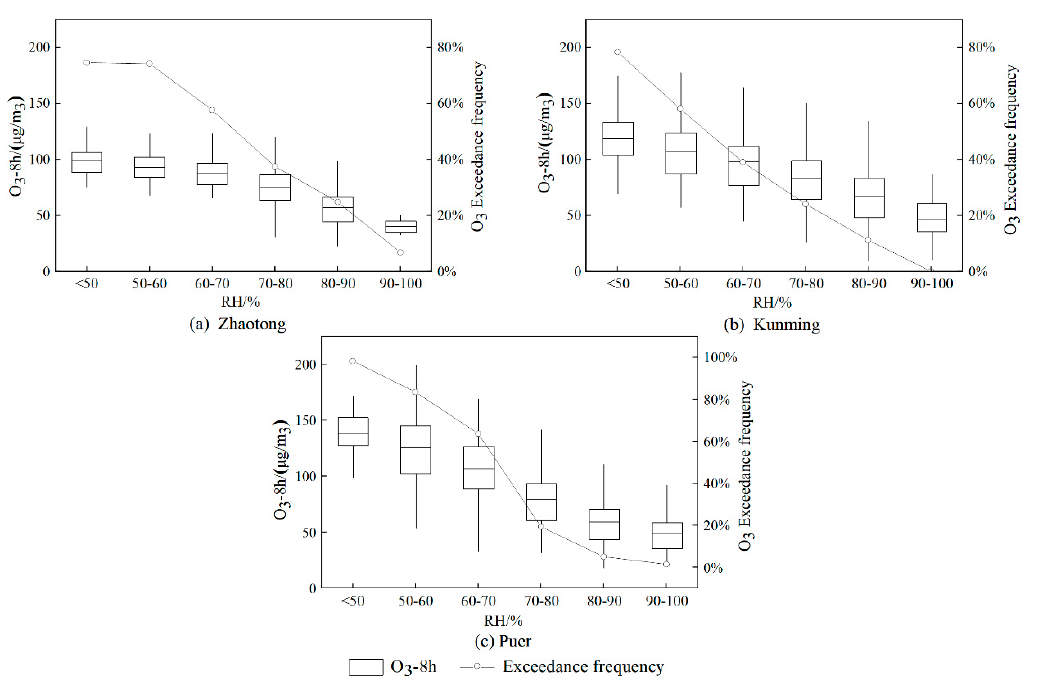
Figure 9. Changes from relative humidity and O 3 concentration, exceeding standard frequency between Zhaotong, Kunming and Pu’er. Table 2. Correlation Analysis of O 3 Concentrations and Humidity in Different